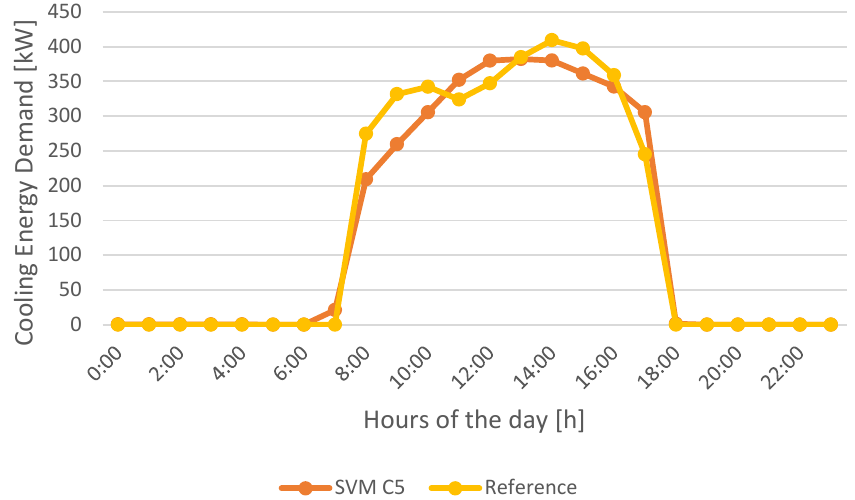
Figure 13. Daily load profile (13 September) comparison between SVM model C5 and reference for the cooling period.